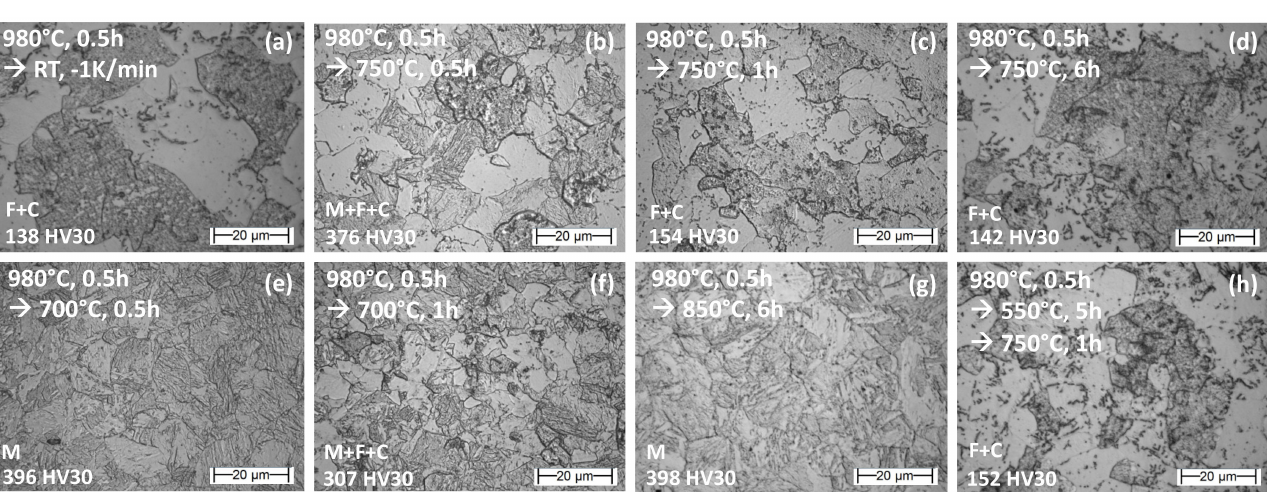
Figure 5. Micrographs of EUROFER97 after austenitization at 980 ◦ C for 30 min and different subsequent tempering steps; ( a ) cooling to room temperature with a constant rate of − 1 K/min (leads to ferrite and carbide formation: F + C); ( b ) isothermal annealing at 750 ◦ C for 30 min (leads to martensite and a fraction of F + C); ( c ) isothermal annealing at 750 ◦ C for 1 h (leads to F + C); ( d ) isothermal annealing at 750 ◦ C for 6 h (leads to F + C); ( e ) isothermal annealing at 700 ◦ C for 30 min (leads to martensite); ( f ) isothermal annealing at 700 ◦ C for 1 h (leads to martensite and a fraction of F + C); ( g ) isothermal annealing at 850 ◦ C for 6 h (leads to martensite); ( h ) isothermal annealing at 550 ◦ C for 5 h followed by isothermal annealing at 750 ◦ C for 1 h (leads to F + C). Note: the final isothermal treatments were followed by air cooling